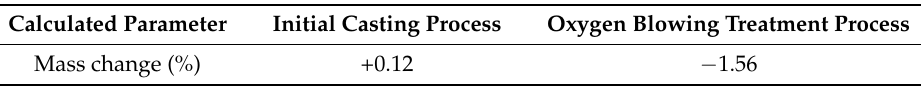
Table 4. Mass balance calculations of initial alloys and alloys treated by oxygen blowing.